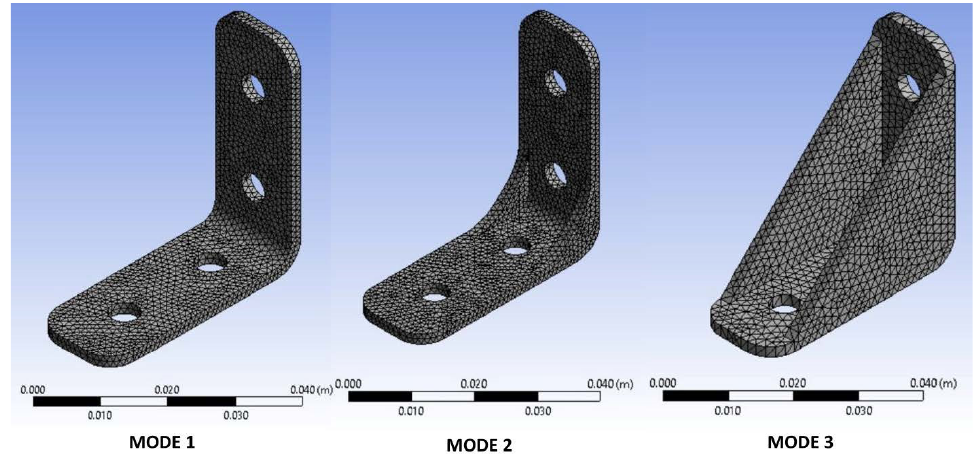
Figure 3. Shows the mesh model of all three brackets.